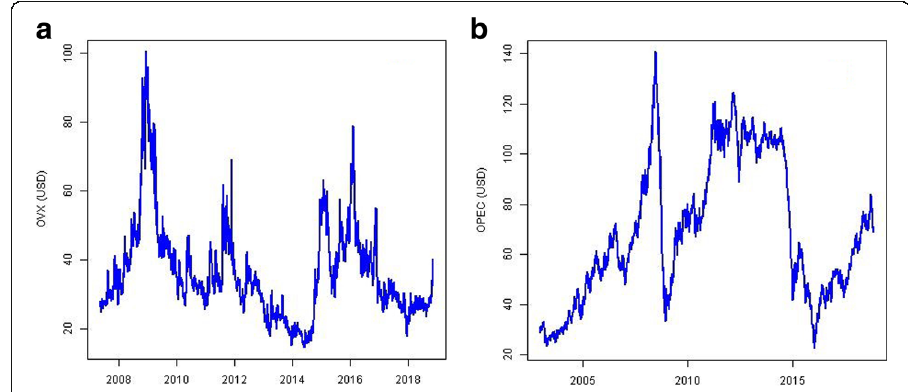
Fig. 2 The historical price data for OVX ( a ), and OPEC ( b